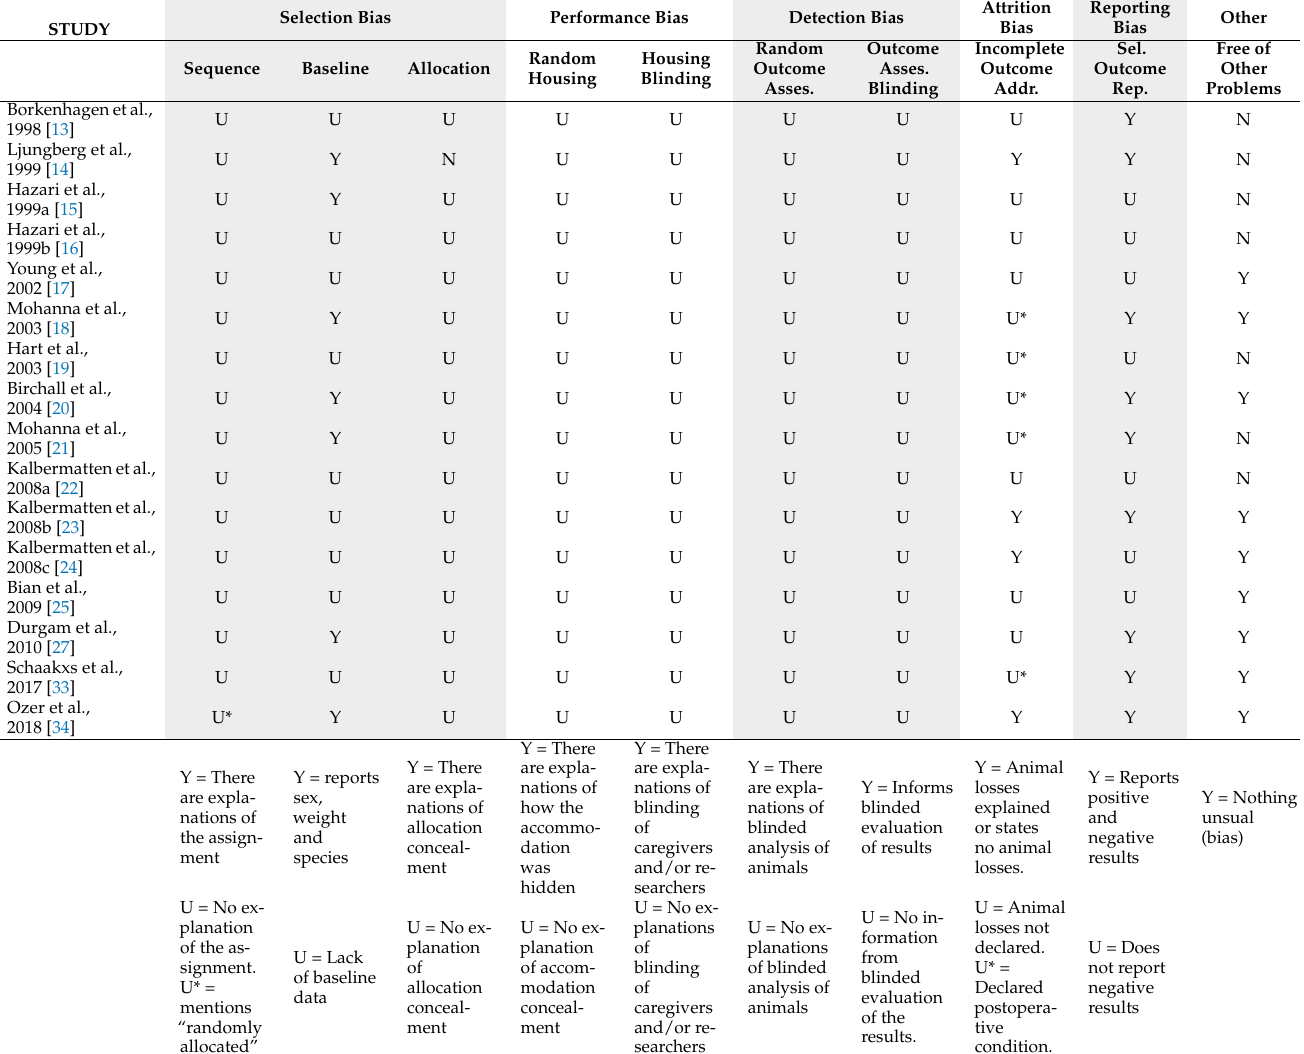
Table 3. Analysis of the risk of bias in animal studies using the SYRCLE RoB tool [42] scale adapted for nerve damage and treated with PHB